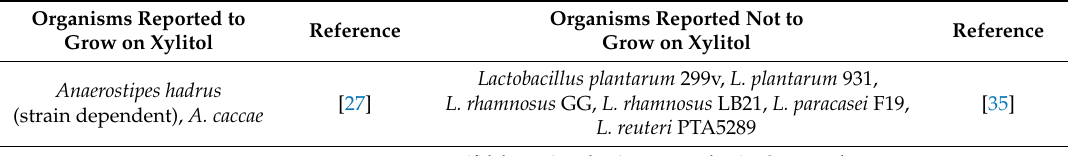
Table 1. Non-exhaustive list of organisms that are able to grow or not to grow in the presence of xylitol, or that have the capacity to metabolize xylitol in vitro or